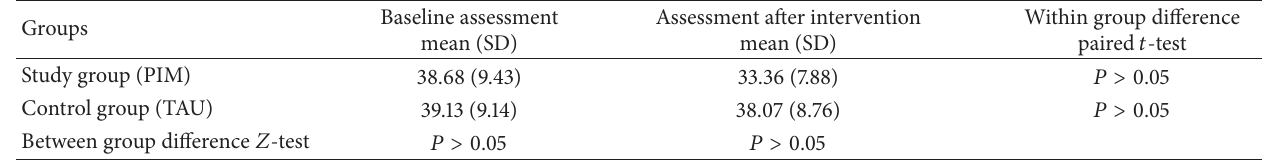
Table 4: State-Trait Anxiety Inventory before and after psychological